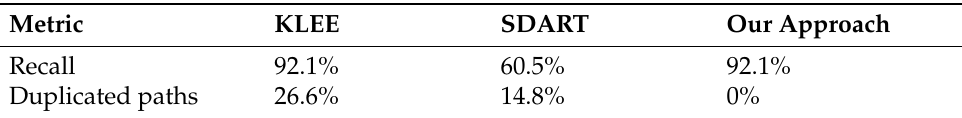
Table 4. Summary of KLEE, SDART, and our approach’s